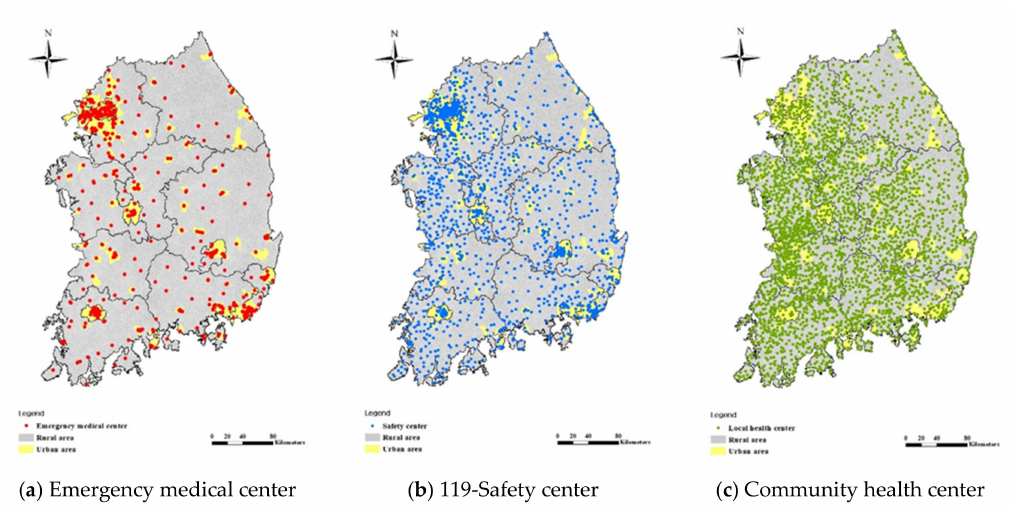
Figure 2. Distribution of medical facilities in Korea. The yellow and gray areas indicate urban and rural areas, respectively. The individual medical facilities are represented by dots. Red dots in ( a ) are emergency medical centers, blue dots in ( b ) are community health centers, and green dots in ( c ) are 119-safety centers. There are 495 emergency medical centers, 3161 community health centers, and 1711 safety